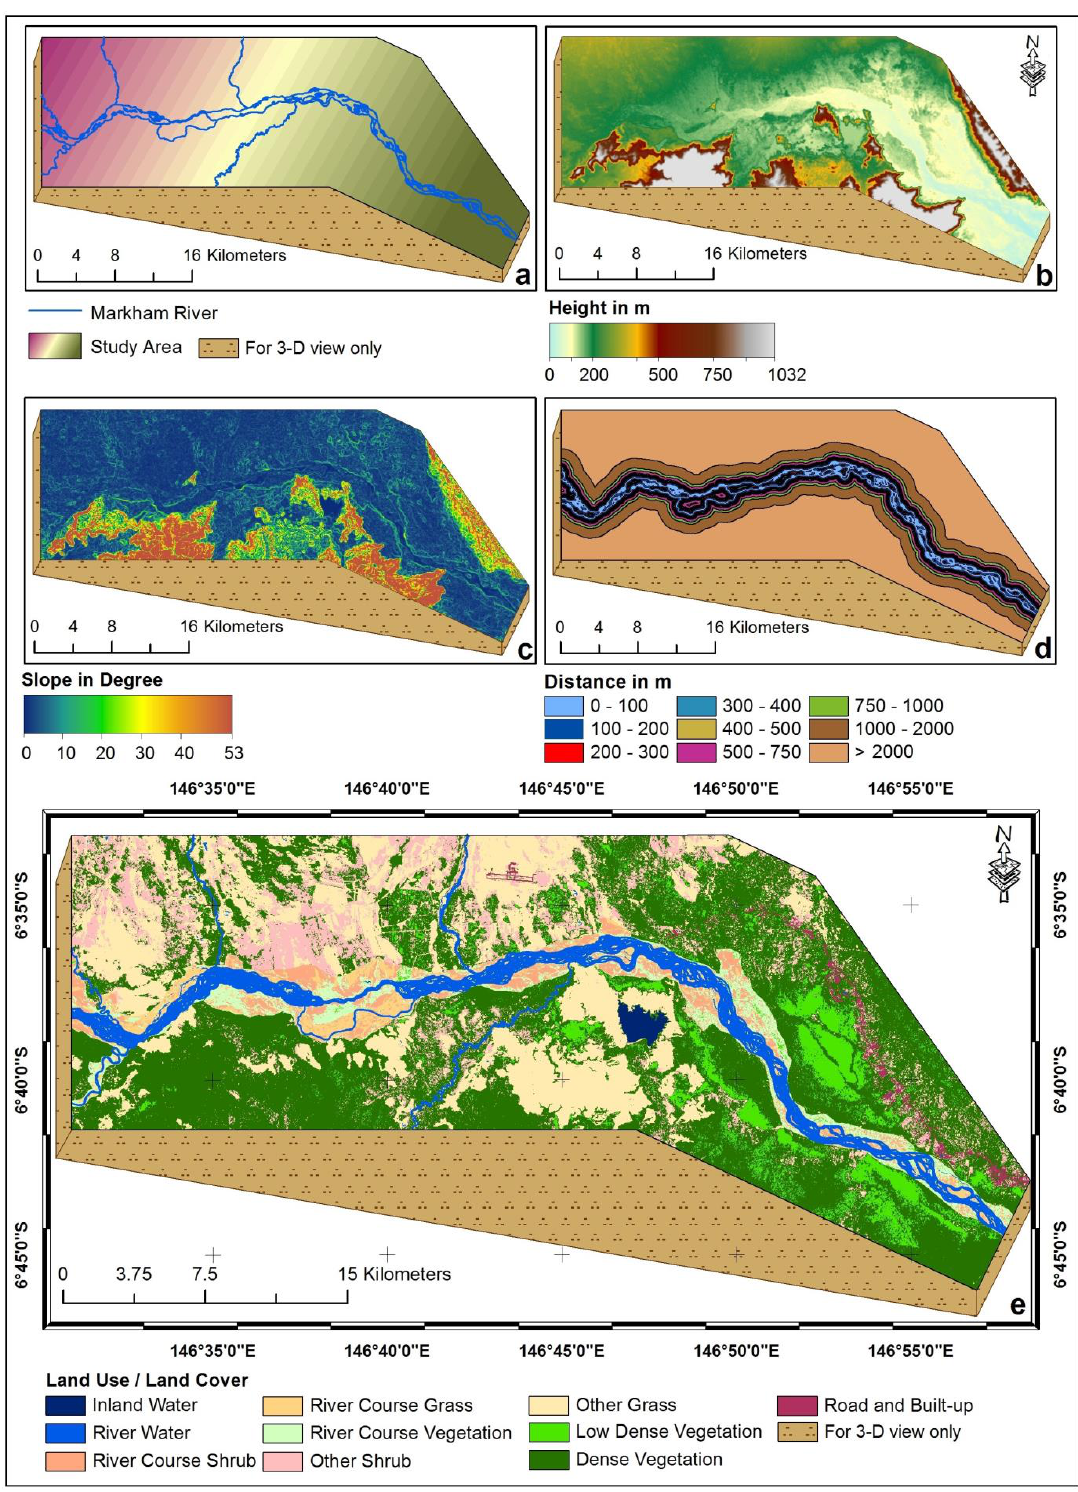
Figure 2. Markham river ( a ), digital elevation model ( b ), slope in degree ( c ), distance from river ( d ), and land use/land cover characteristics ( e ), derived from ASTER-DEM and Landsat 8, OLI satellite image.